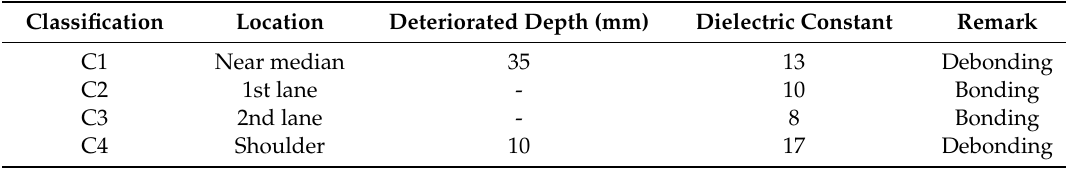
Figure 12. Evaluation of condition of asphalt-covered concrete bridge decks through core extraction from the four locations in the target bridge (“J” bridge): ( a ) core 1 (C1), ( b ) core 2 (C2), ( c ) core 3 (C3), and ( d ) core 4 (C4) (see Figure 12). Depth of deterioration in concrete decks and the condition of water-proofing-layer in the A/C interface were evaluated. Table 4. Investigation result of core samples (1st span).